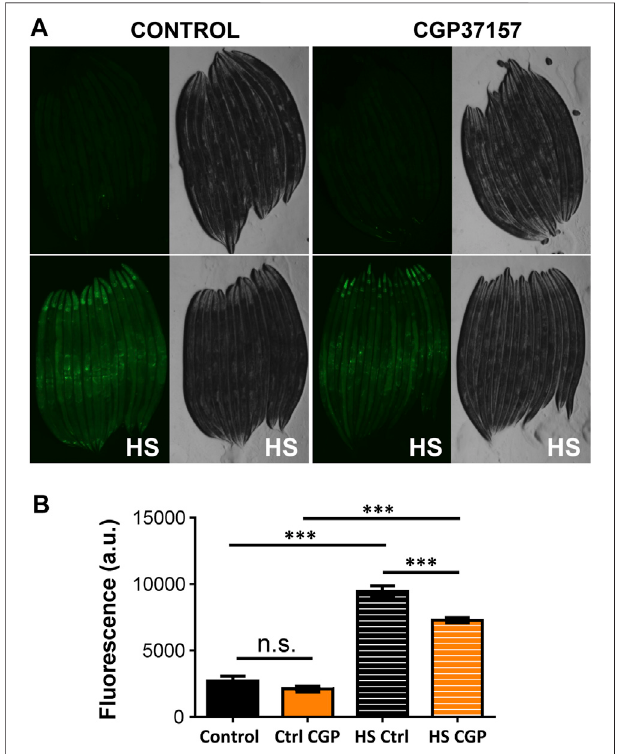
FIGURE 4 | Effect of CGP37157 on cytosolic stress. hsp-16.2 expression was evaluated at day 3 of adult life using the strain TJ375, that induces GFP expression when hsp-16.2 is transcribed. (A) shows the mean fl uorescence obtained before (upper panels) and after (lower panels) a temporary heat shock (HS) treatment of 2 h at 35 ° C followed by overnight recovery, eitherinthe absence (leftpanels) or inthepresence (rightpanels) of 50 µM CGP37157. (B) shows the mean fl uorescence obtained in each condition compared with the ANOVA test ( n (cid:2) 23 to 37 worms/condition. *** p <